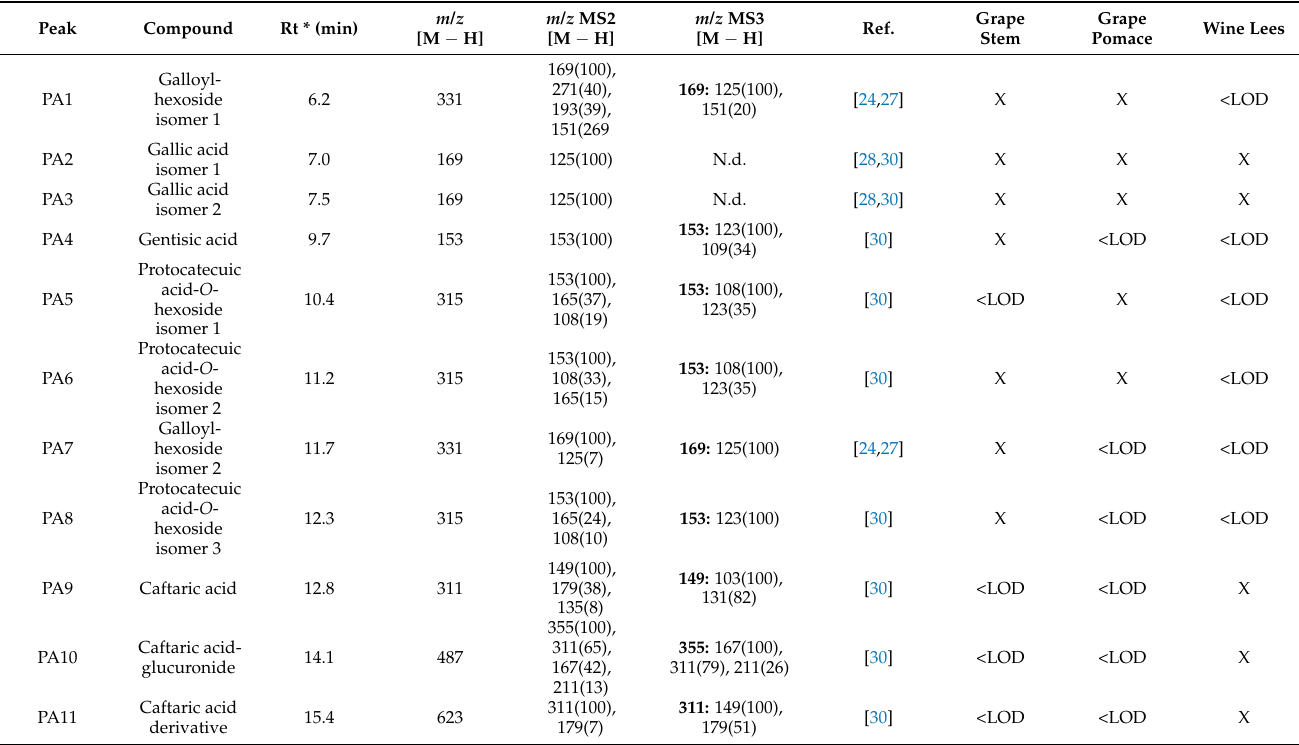
Figure 3. Chromatogram recorded at 320 nm representative of the phenolic acids (PA) and stilbenes (ST) recorded in grape stems, grape pomace, and wine lees. Identification of the peaks annotated according to Tables 2 and 3, respectively. Table 2. Identification of phenolic acids in grape ( Vitis vinifera L. var. ’Monastrell’) stem, pomace, and wine lees by HPLC-PDA-ESI-MSn operating in negative mode.